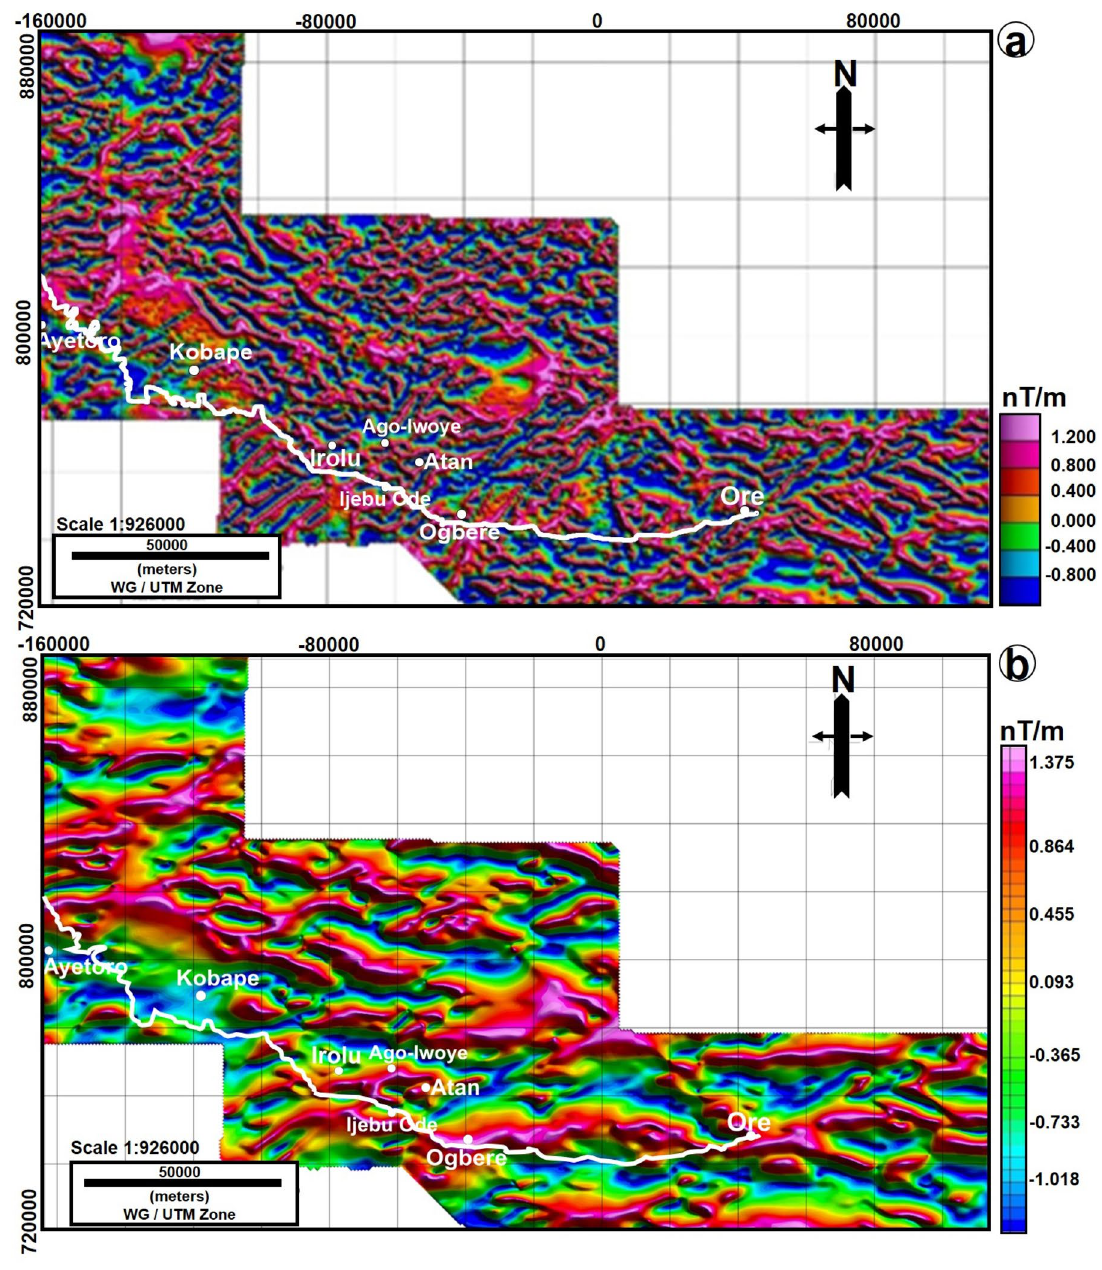
Figure 4. ( a ) Tilt Derivatives of the RMI show similar trend as that observed on the RMI. This is at variance with the geologic boundary of 36 . ( b ) Tilt Derivatives of the RTE and Upward Continuation of 2000 m. The figure was made using Oasis Montaj software (https ://www.seequ ent.com/produ cts-solut ions/geoso ft-oasis -monta j/) and edited in CorelDRAW2017, https ://www.corel